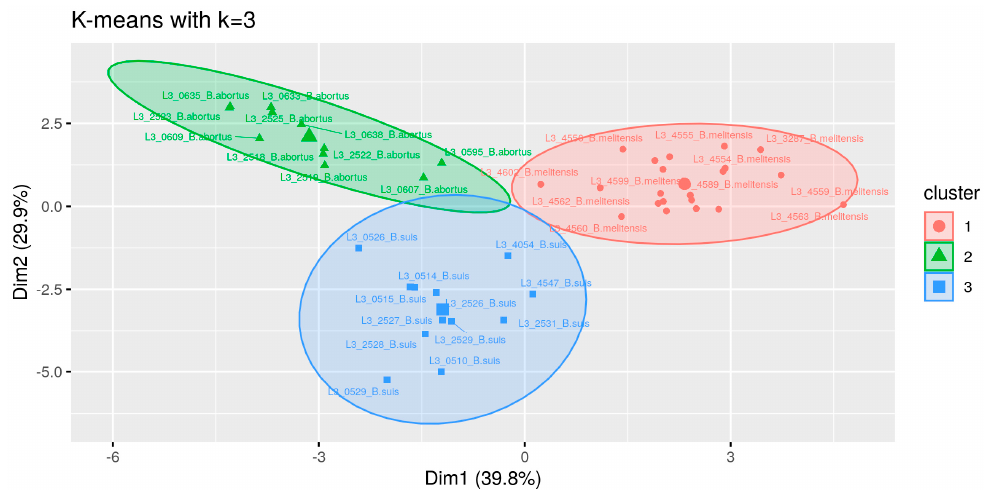
Figure 2. Illustration of the k -means model with the optimal number of clusters ( k = 3). The function fviz_cluster from the R-package “factoextra” was used to plot the data points according to the first two principal components that explained the majority of the variance. The figure shows species- specific clustering. The optimal number of clusters is three, with an SC value of 0.39. The silhouette coefficient was computed using the silhouette function from the “cluster”